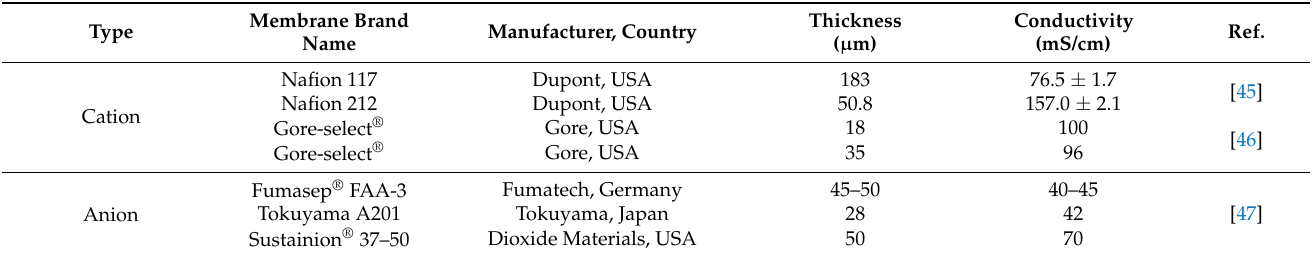
Table 2. Ion conductivity property of membrane by the